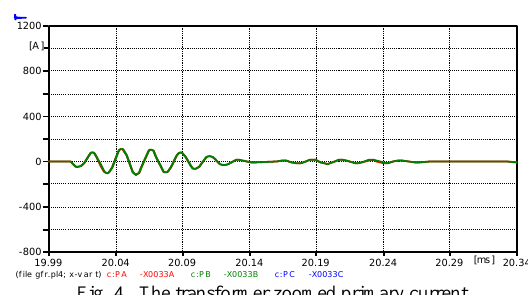
Fig. 4. The transformer zoomed primary